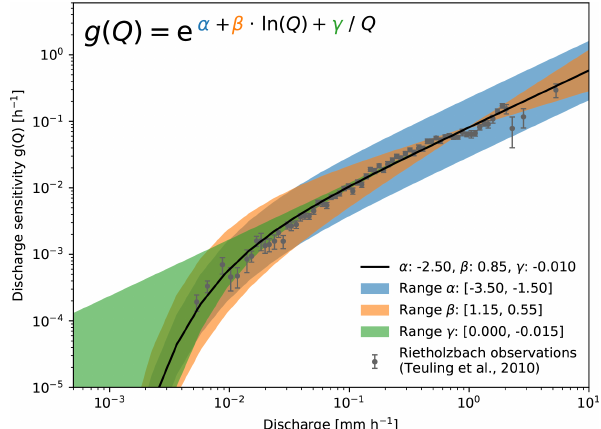
Figure 2. Parametrization of the discharge sensitivity, including the effects of the three parameters. α affects the intercept, β affects the slope and γ affects the curvature at low discharge values. Parameter values for each parameter are given in the legend as their min–max